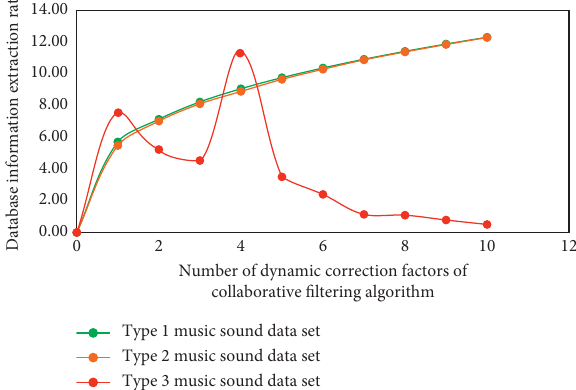
Figure 6: Database information extraction rate under different number of dynamic correction factors. Figure 7: Accuracy changes corresponding to different levels of data transmission rates in the EFK